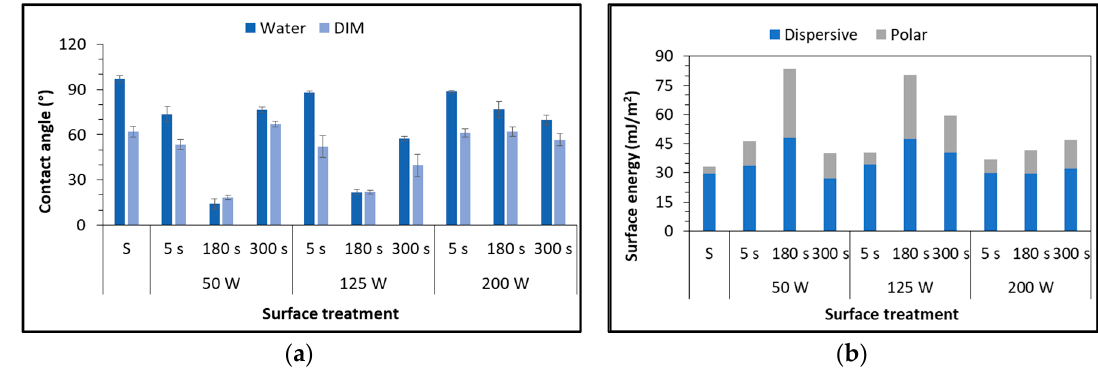
Figure 3. Static water contact angle ( a ) and surface free energy ( b ) of PP substrates as a function of plasma parameters, using oxygen as working gas.